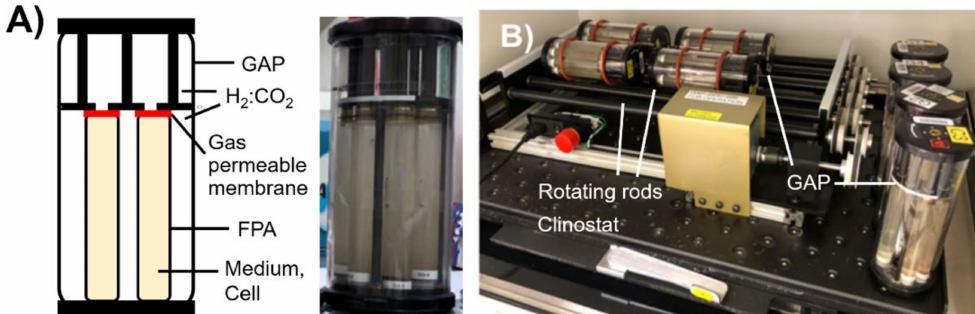
Figure 1. Experimental set-up for incubation of A. ferrooxidans under simulated microgravity and Earth gravity conditions. ( A ) Schematic image and a photo of BioServe’s fluid processing apparatus (FPA) and group activation pack (GAP) used for cultivation. ( B ) A photo showing GAPs kept rotating on a clinostat to simulate a microgravity condition and standing vertically to represent the Earth gravity